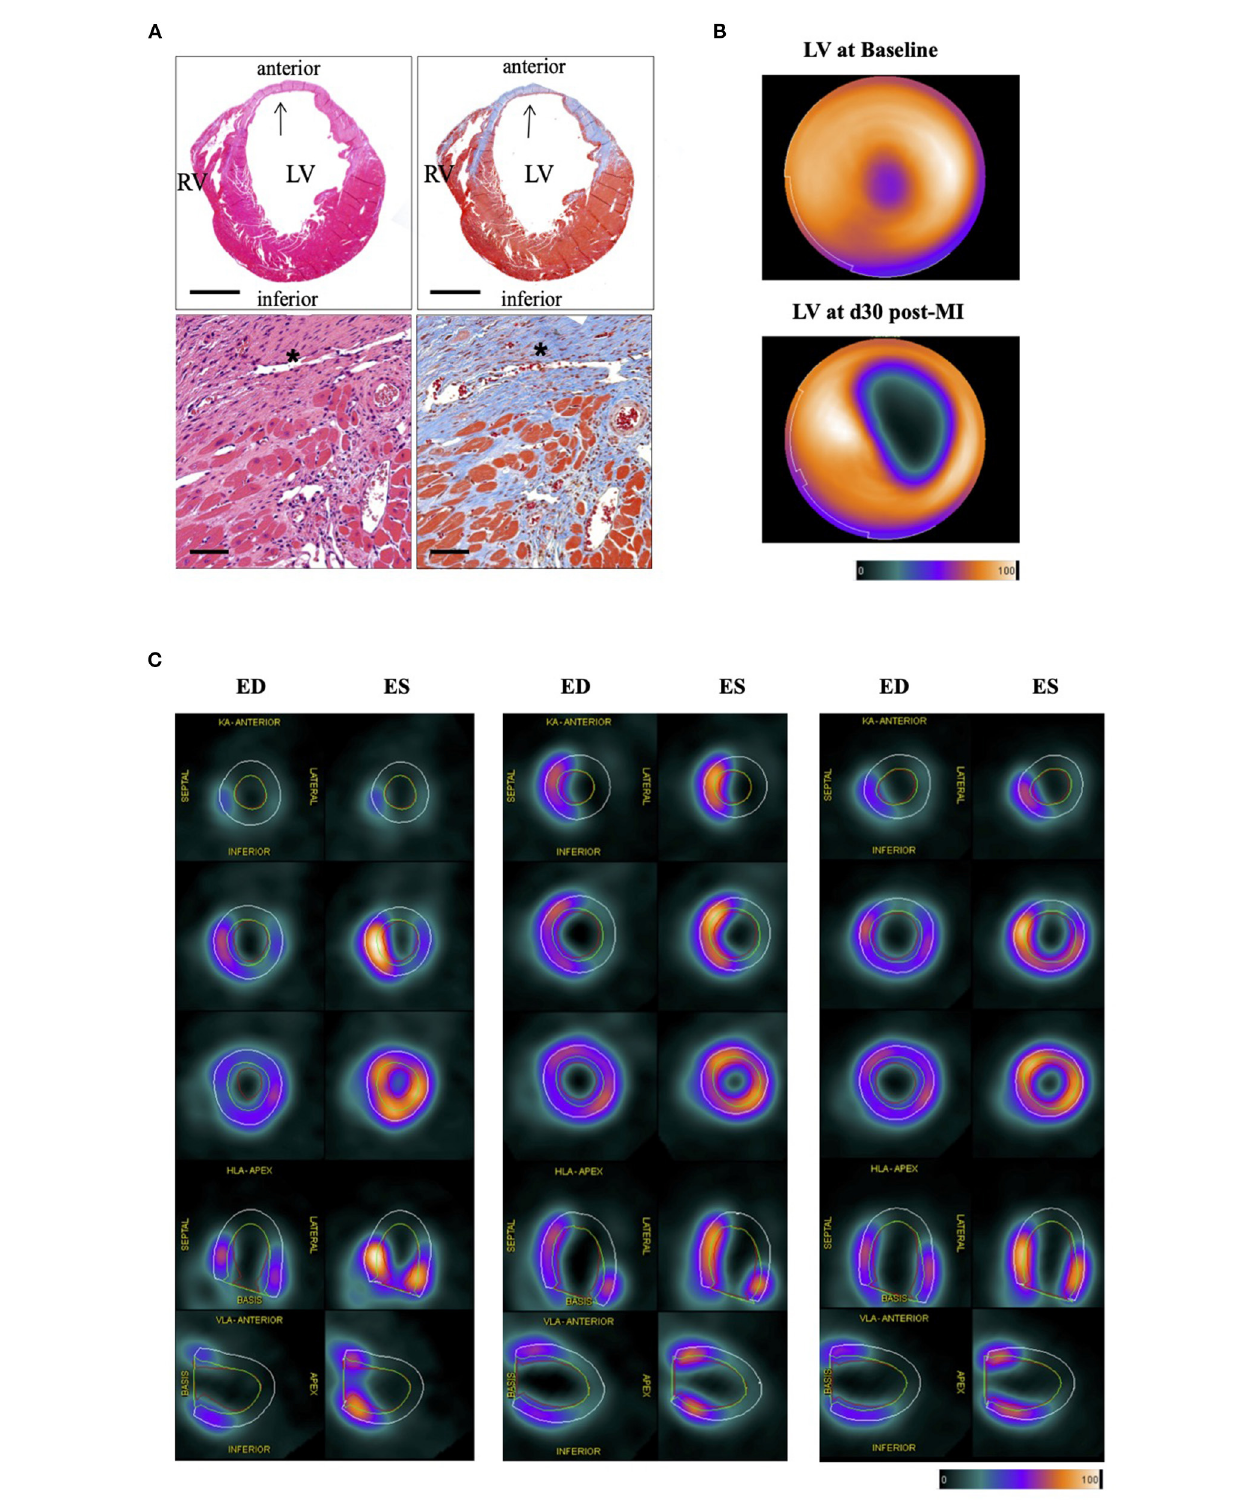
FIGURE 1 | Histological and PET imaging of murine myocardial infarction. (A) Histology section of the heart 30 days after LAD ligation. HE-Staining (left) and Masson’s trichrome staining (right). Stars and arrows indicate the magnified infarct scare area in the left ventricular (LV) wall (blue). Right ventricle (RV). Bar equals 100 and